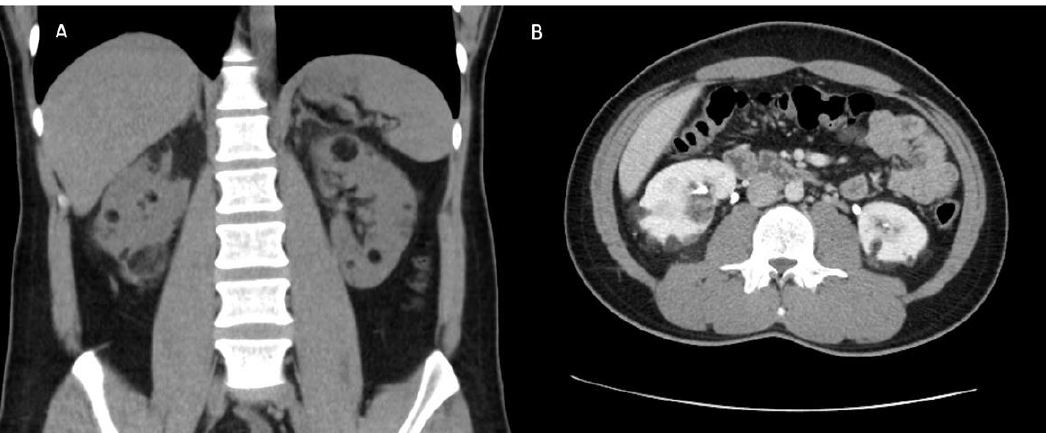
Figure 1. Coronal ( A ) and axial ( B ) contrast computed tomography post angioembolisation of largest AML, demonstrating presence of multiple kidney angiomyolipomas, largest measuring 3 cm in diameter.